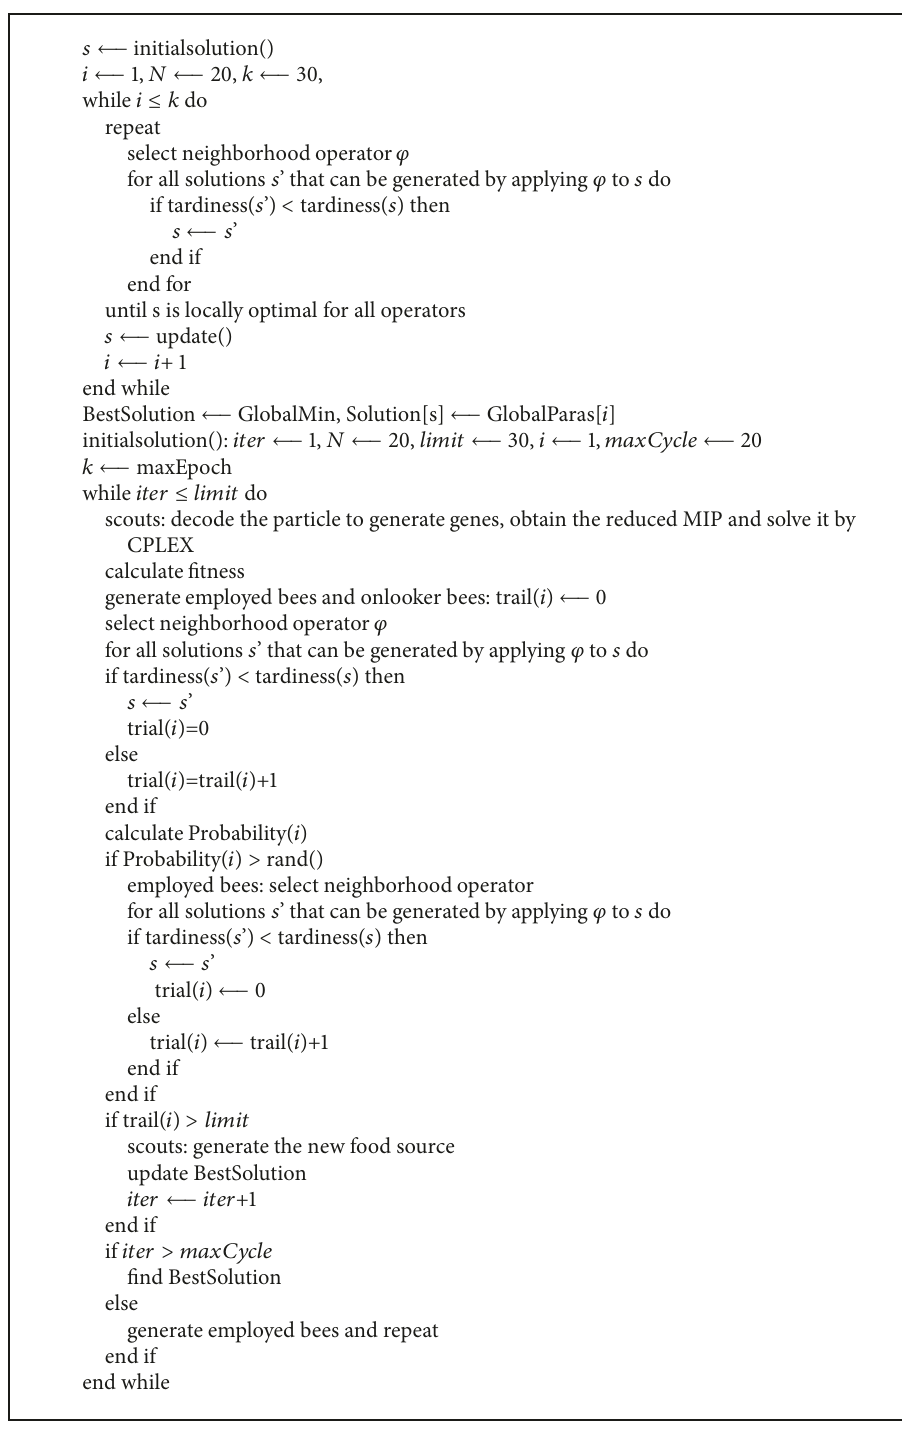
Algorithm 2: PSOB algorithm main